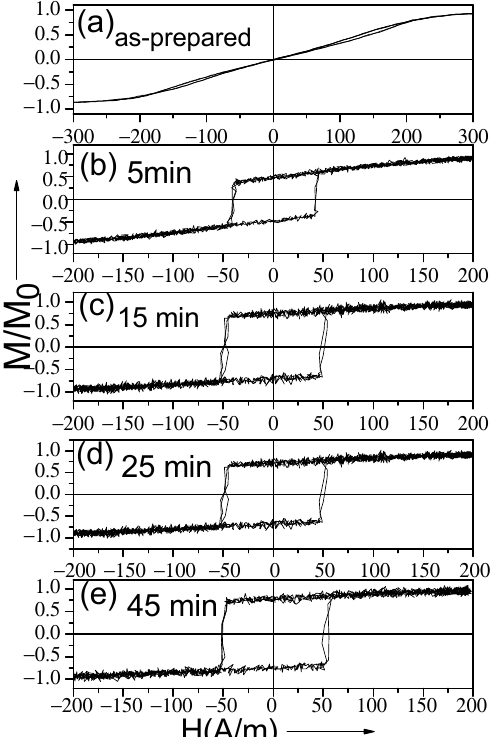
Figure 14. The hysteresis loops of as-prepared ( a ) and annealed for 5 ( b ), 15 ( c ), 25 ( d ) and 45 ( e ) min Co 69.2 Fe 4.1 B 11.8 Si 13.8 C 1.1 microwires annealed at T ann = 250 ◦ C. Adapted from [96] Copyright © 2014 Springer